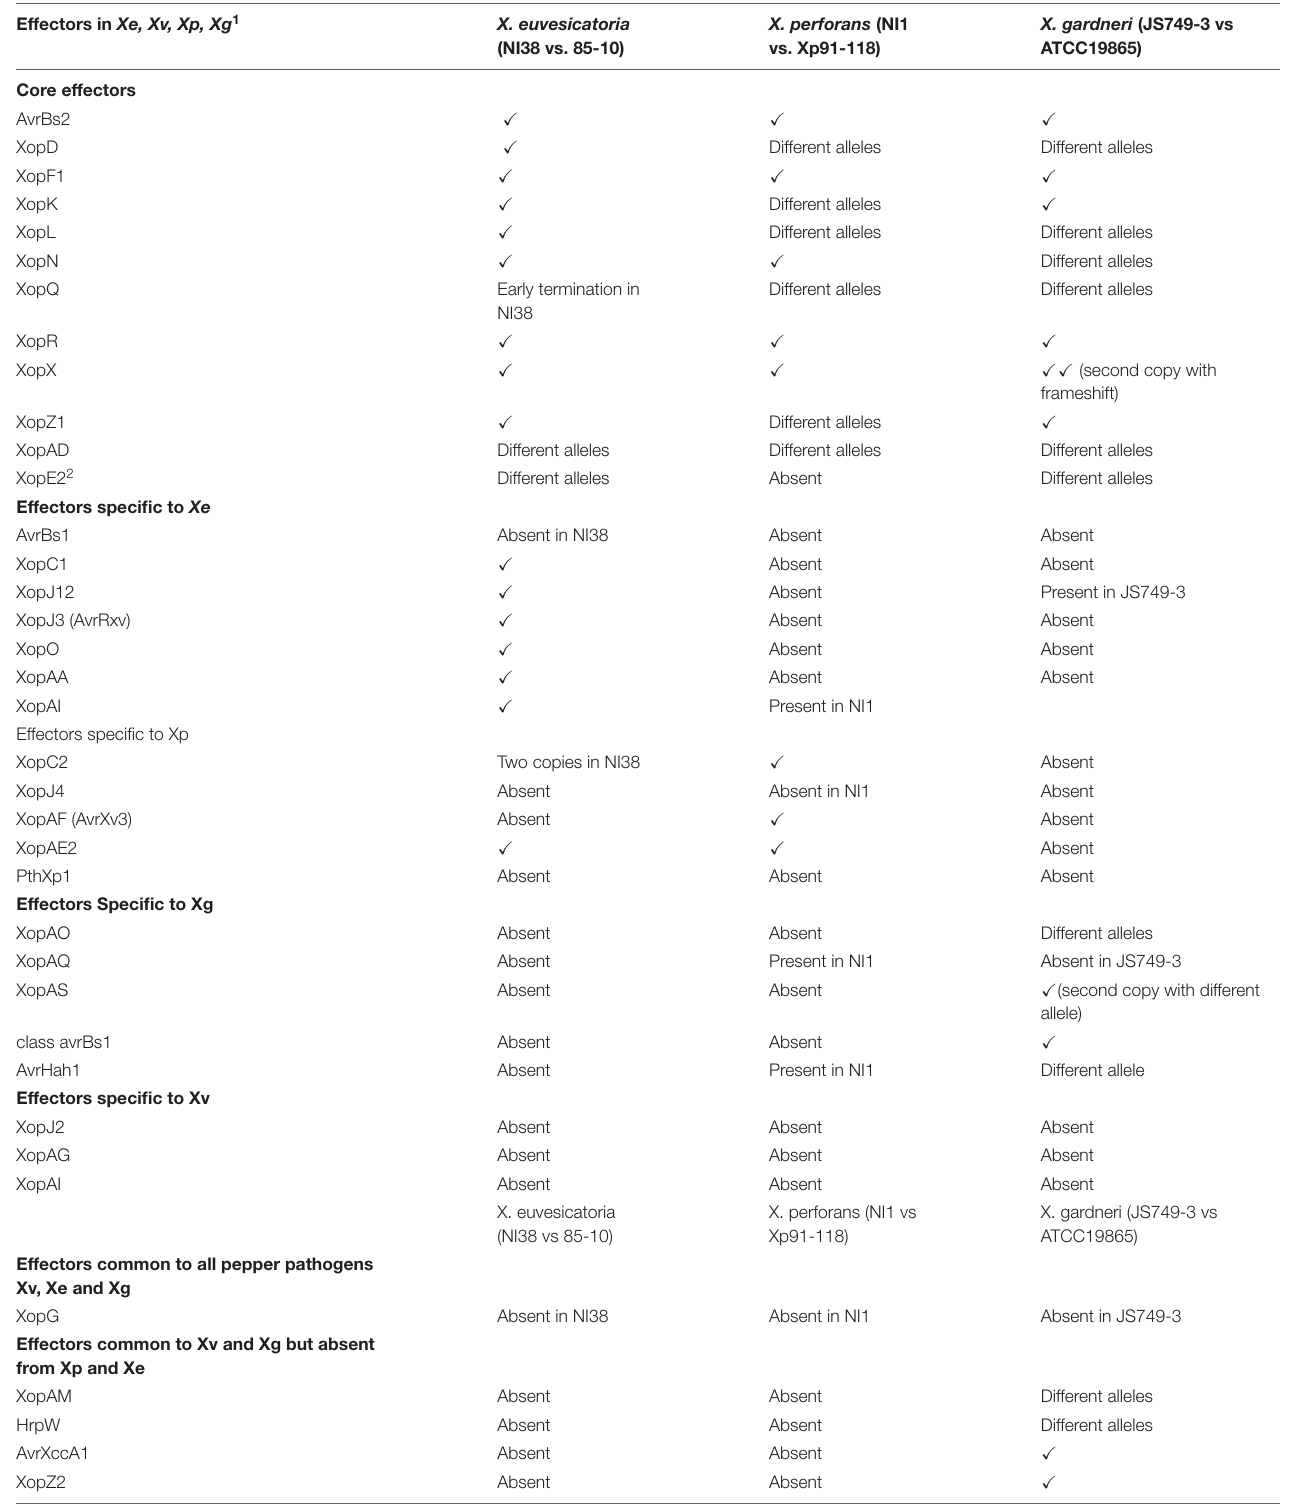
TABLE 2 | Effector diversity in reference strains of X. euvesicatoria , X. perforans , and X. gardneri compared with African strains of same species. Effectors in Xe, Xv, Xp, Xg